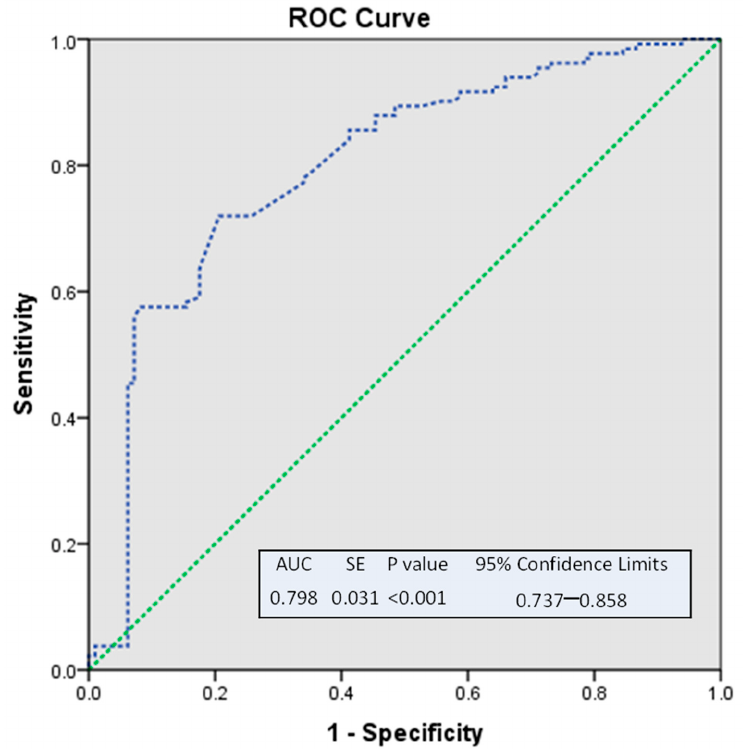
Figure 4. ROC analysis of age as a predictor of lipoprotein(a) levels in all participants. Note: We dichotomized the age into two groups based on the cut-off of 50 years old [7]. ROC analysis was performed to see the predictive value for Lp(a) levels. It revealed AUC 0.798, p < 0.001. It showed that age significantly strongly predicts high Lp(a) levels in women. Abbreviations: ROC curve: receiver operating characteristic curve; AUC: area under the receiver operating characteristic